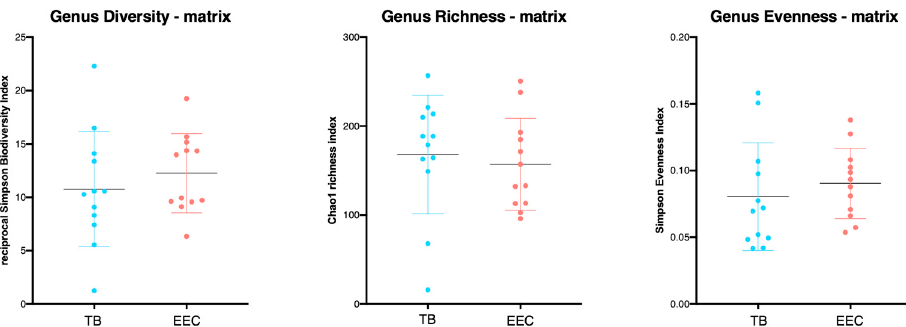
Figure 2. Richness, evenness and α -diversity from external ear canal and tympanic bulla in 12 ears from 6 healthy Beagle dogs. No differences of the Chao1 index (richness estimator), reciprocal Simpson index (biodiversity estimator) or the population evenness, derived from Simpson index, were observed between the EEC and the TB in experimental Beagle dogs. (TB, tympanic bulla; EEC, external ear canal).